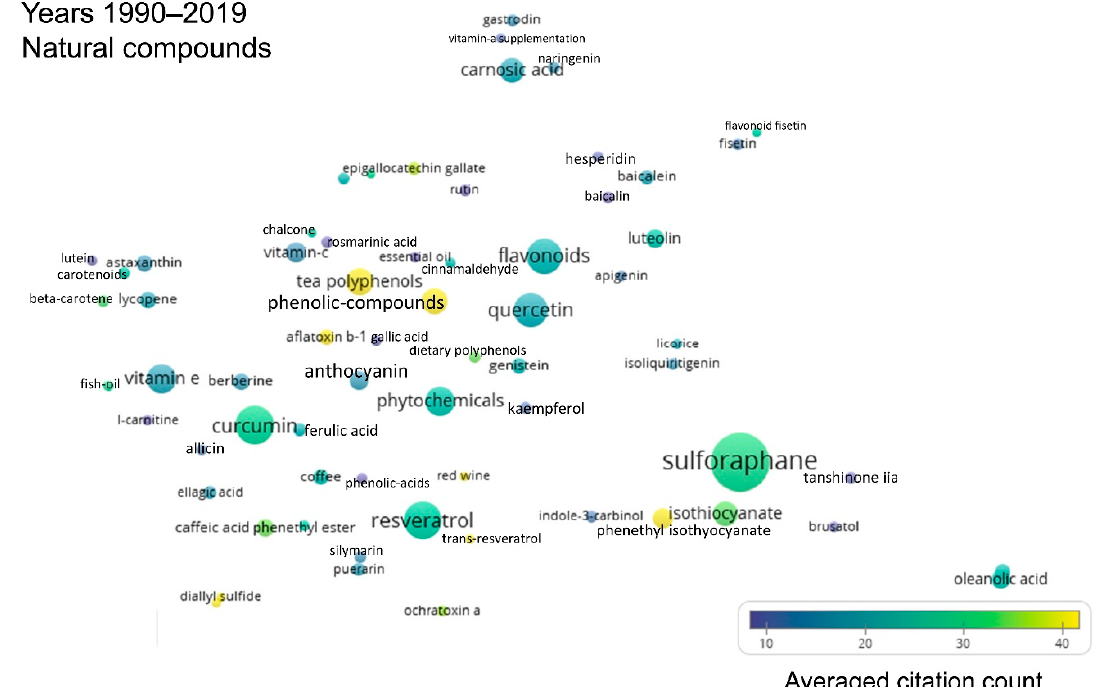
Figure 8. Country term maps for years 1990–2019. ( A ) Bubble map showing collaborations between countries on Nrf2-related research. Countries with at least 20 publications are included. The smaller the distance between two bubbles, the higher the frequency with which these two countries appear in the same paper in the author list. A larger bubble indicates a higher number of publications. A bubble’s color indicates the average number of citations received by the papers published by a country. ( B ) Bubble map showing the frequency with countries cite each other in their Nrf2-related papers. Countries with at least 20 publications are included. The smaller the distance between two bubbles, the higher the frequency with which each country cites the other in Nrf2-related papers. A larger bubble indicates a higher number of publications. A bubble’s color indicates the average publication year of the Nrf2-related papers published by a country. Note that “England”, “Scotland”, “Wales” and “Northern Ireland” records from “Web of Science” were combined into “UK”. Countries are presented with their alpha-3 code based on the ISO 3166 international standard.